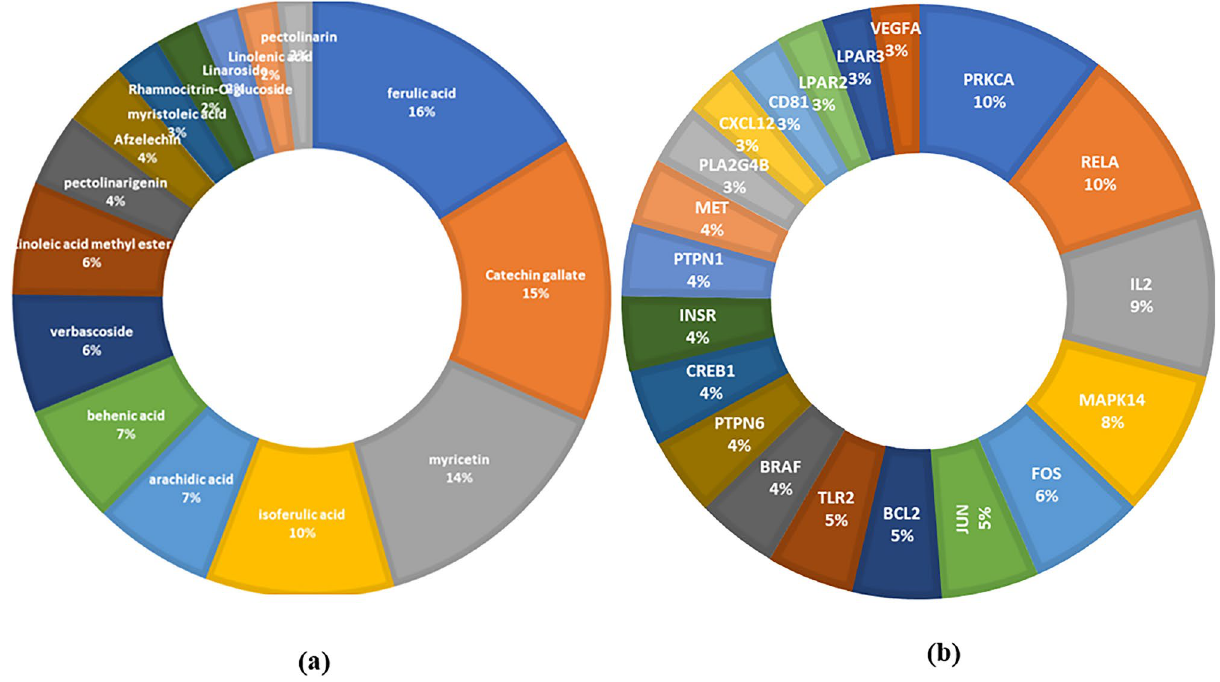
Figure 2. Doughnut charts showing the distributions % of the compound–target gene (C–T) interactions on L. camara constituents ( a ) and the identified inflammation-related proteins ( b